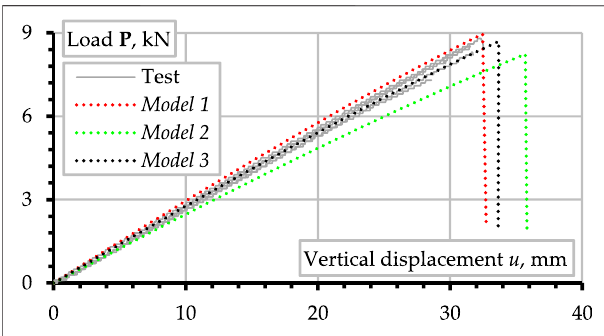
FIGURE 13 | Comparison of measured and numerically predicted load- vertical displacement diagrams at the U GIRA pro fi le mid-span.